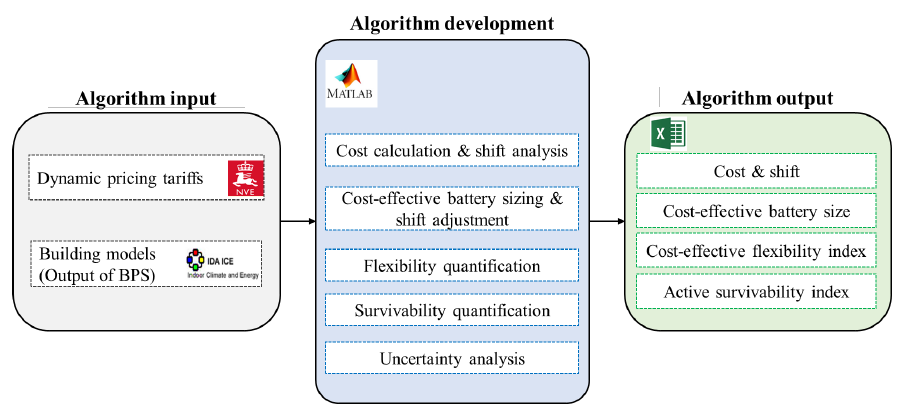
Figure 1. The conceptual framework of the